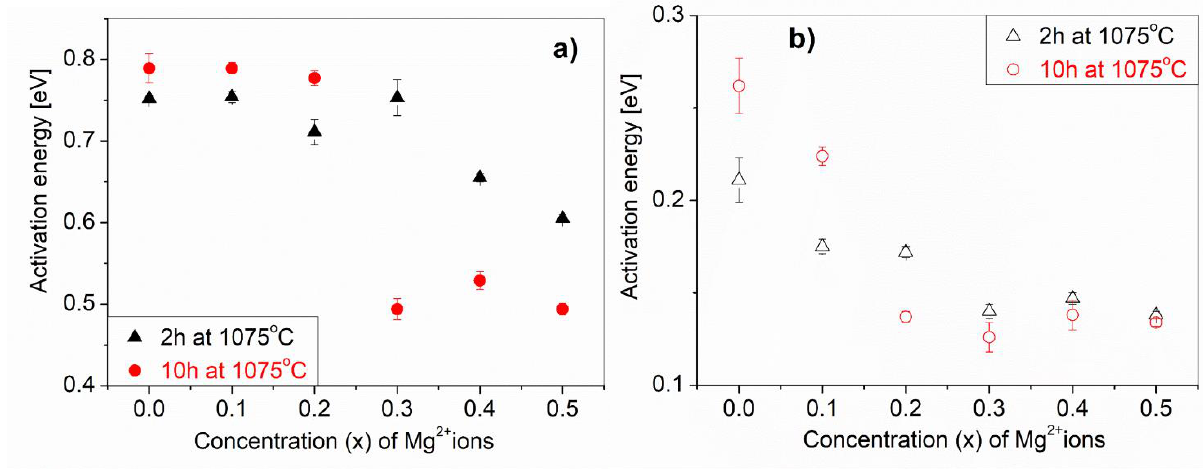
Figure 10. The dependence of the activation energy of the conduction process ( a ) and the dielectric relaxation ( b ) from the amounts of Mg 2+ (x) for CaCu 3−x Mg x Ti 4 O 12 solid solutions.